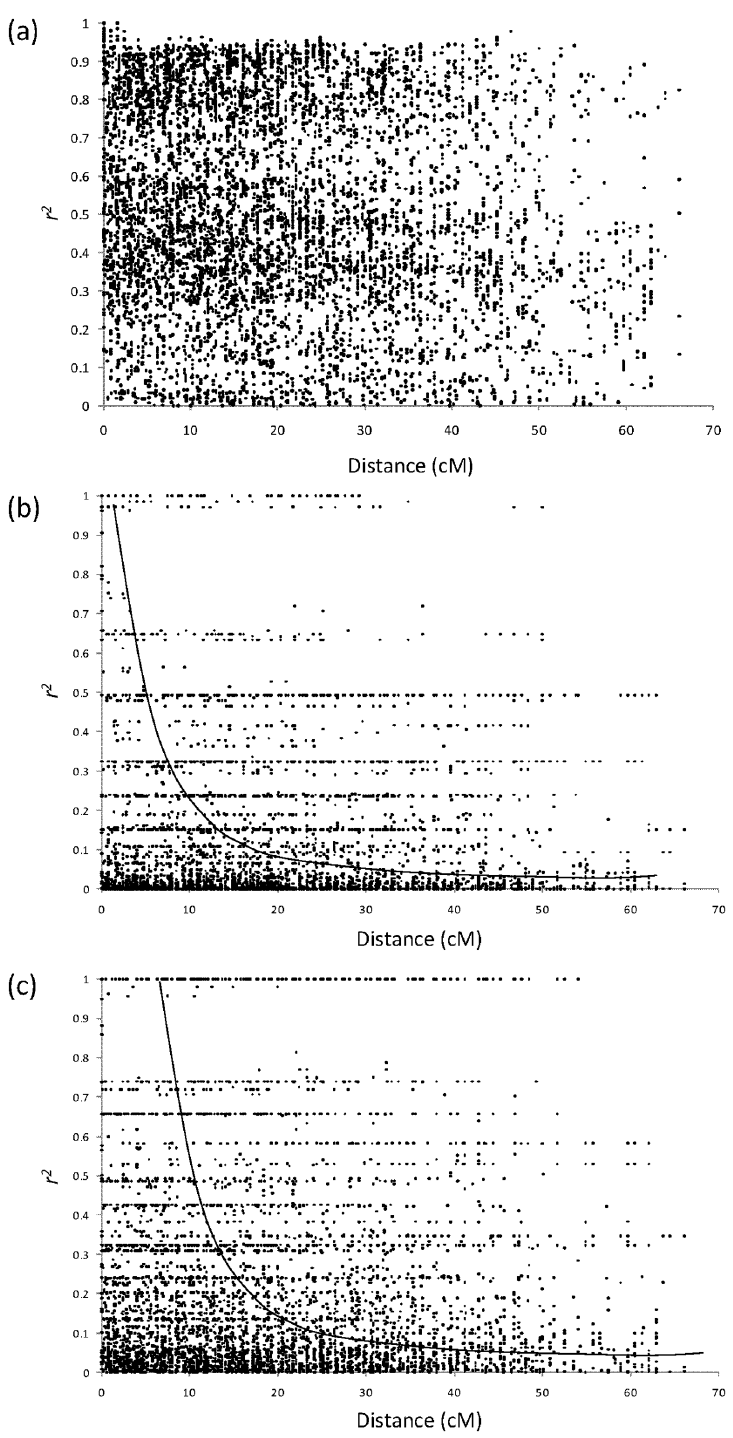
Fig 6. Relationship between D 0 and r 2 for the SNP markers.